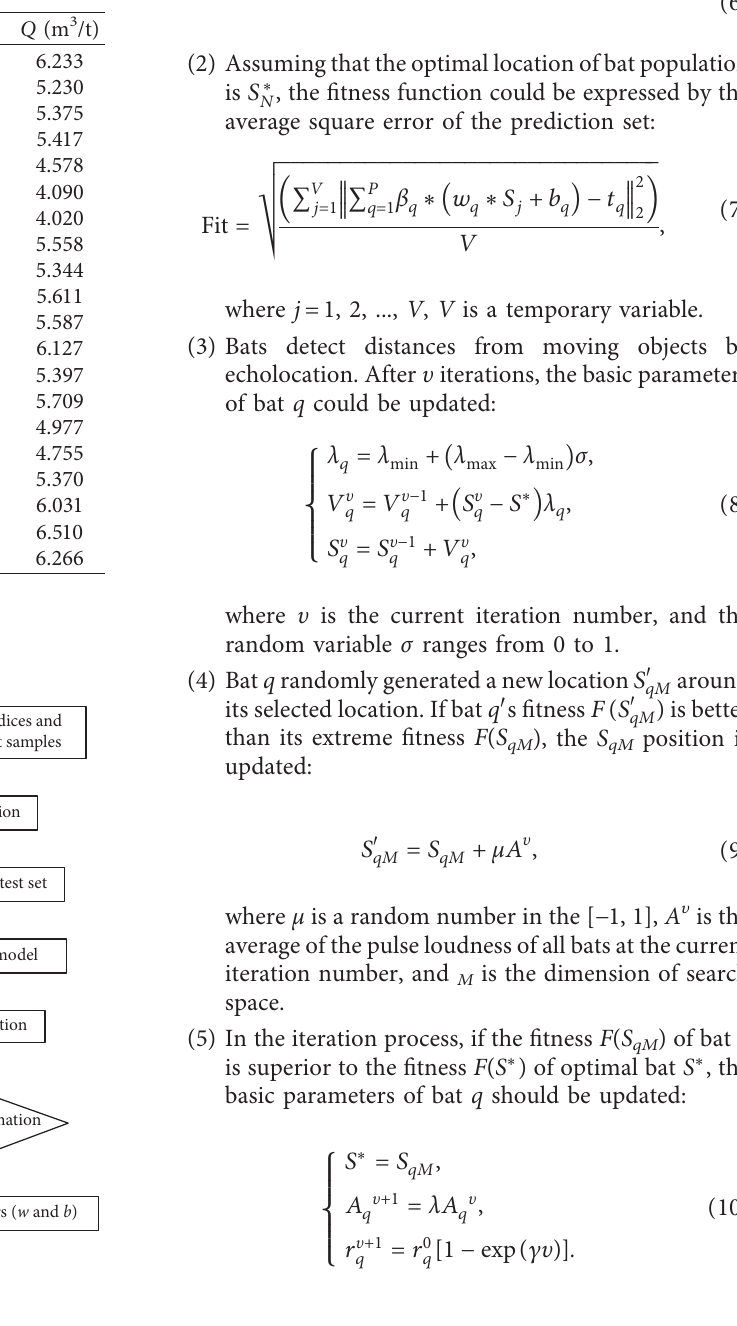
Figure 3: Corresponding diagram of drilling cuttings indices and residual gas content in coal seam. Table 1: Sample dataset for drilling cuttings indices and residual gas content in coal seam.